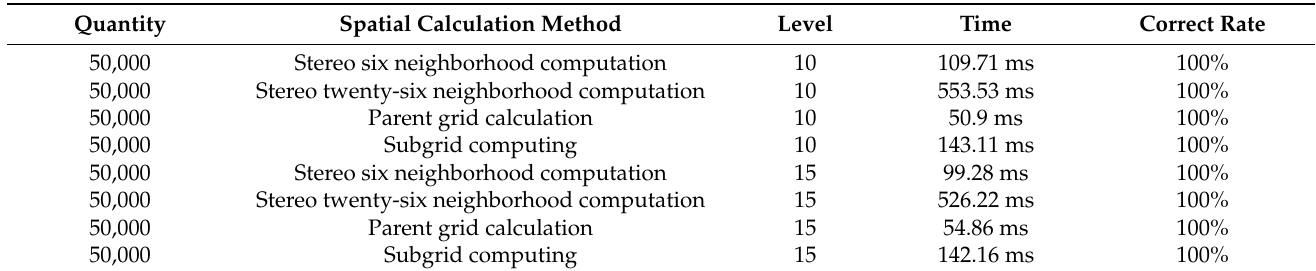
Table 5. Space computing experiment results